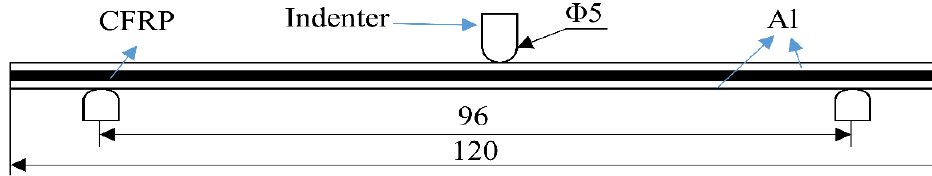
Figure 4. Dimensions of the bending